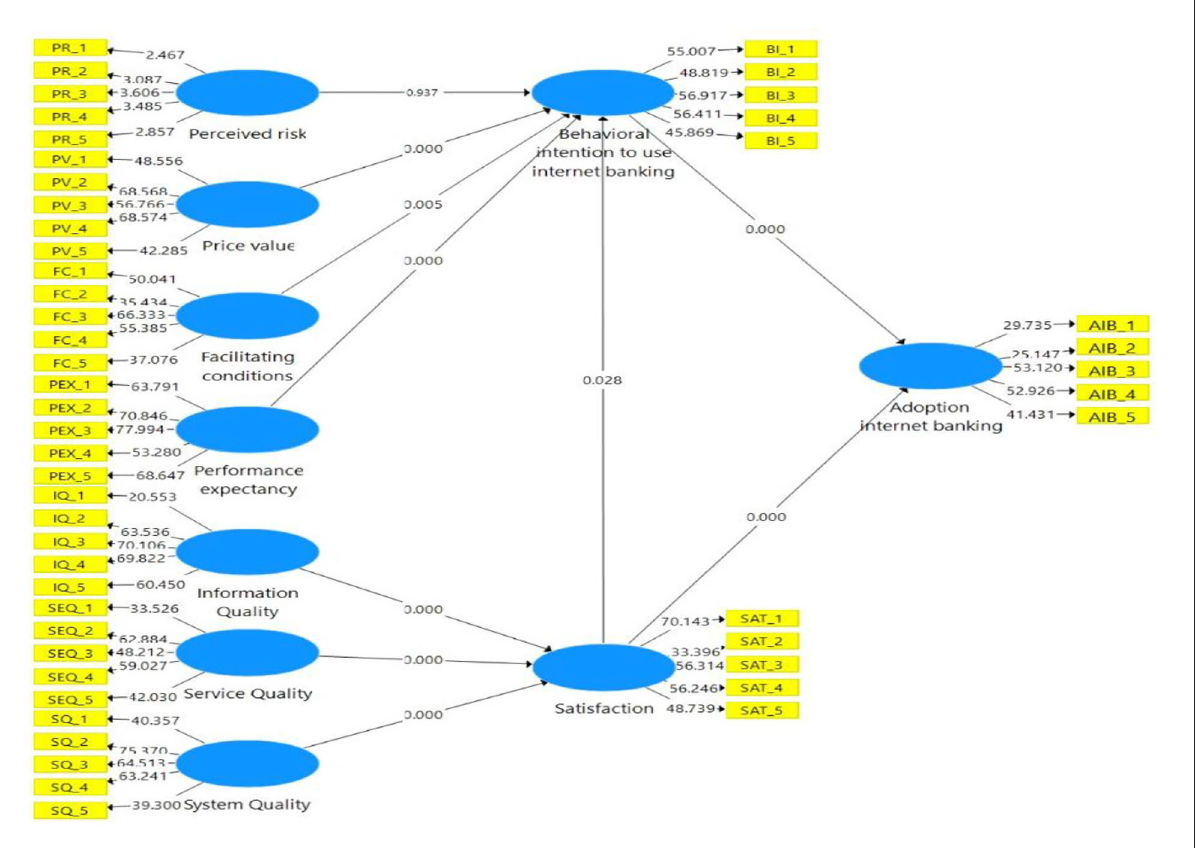
FIGURE2 Coefficients of the